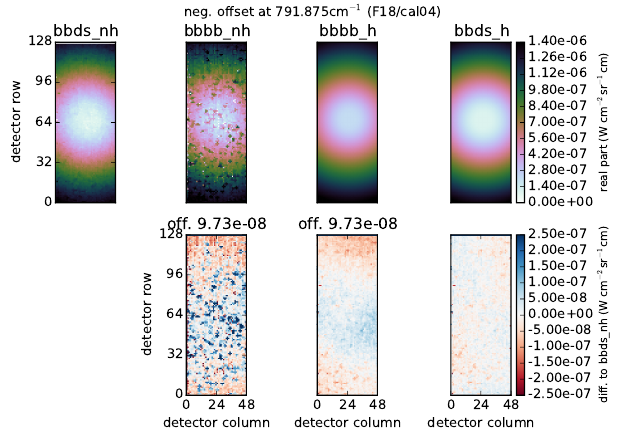
Figure 2. Real part of the NCO for different calibration methods at 791.875cm − 1 . The leftmost image shows the BB-DS reference without pseudo-hyperbola fit. The following two are the values for the original BB-BB calibration and the corresponding pseudo- hyperbola, and the last panel shows an application of the pseudo- hyperbola to the BB-DS calibration. The images in the second row show the difference between the NCO values and those for the BB- DS reference. An offset value given above a plot indicates that all values are to be understood as with this value